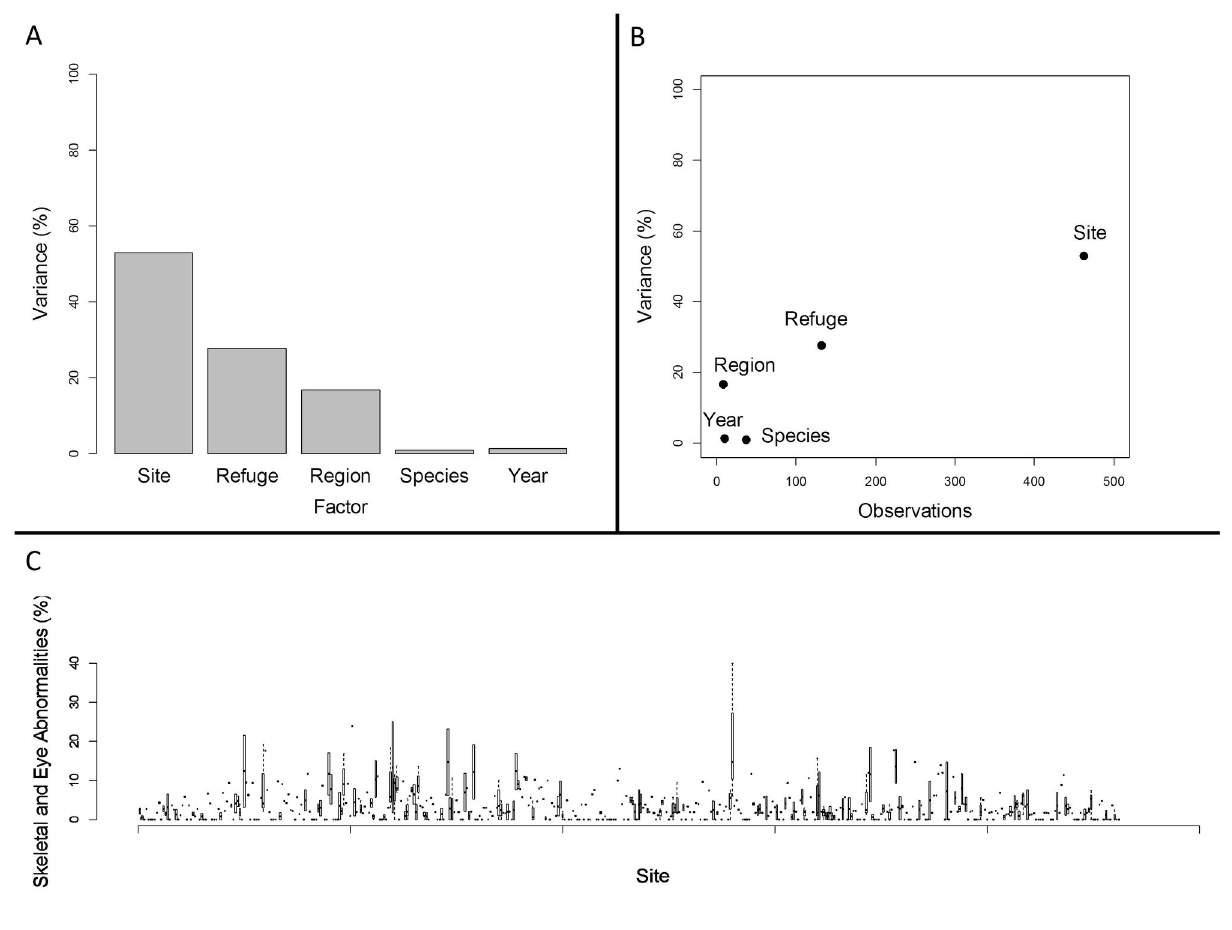
Figure 3. Variation in amphibian abnormalities. (A) Percentage of variance attributable to each factor tested in hierarchical models, which are shown as bars along the labeled X axis. Site is the individual wetland, Refuge is the USFWS Refuge, and Region is the USFWS Region (Figure S12). (B) Shows the same variance estimates plotted against the number of observations for each factor. (C) Box plots showing variation in abnormality prevalence during repeated sampling at individual sites (N=462). doi: